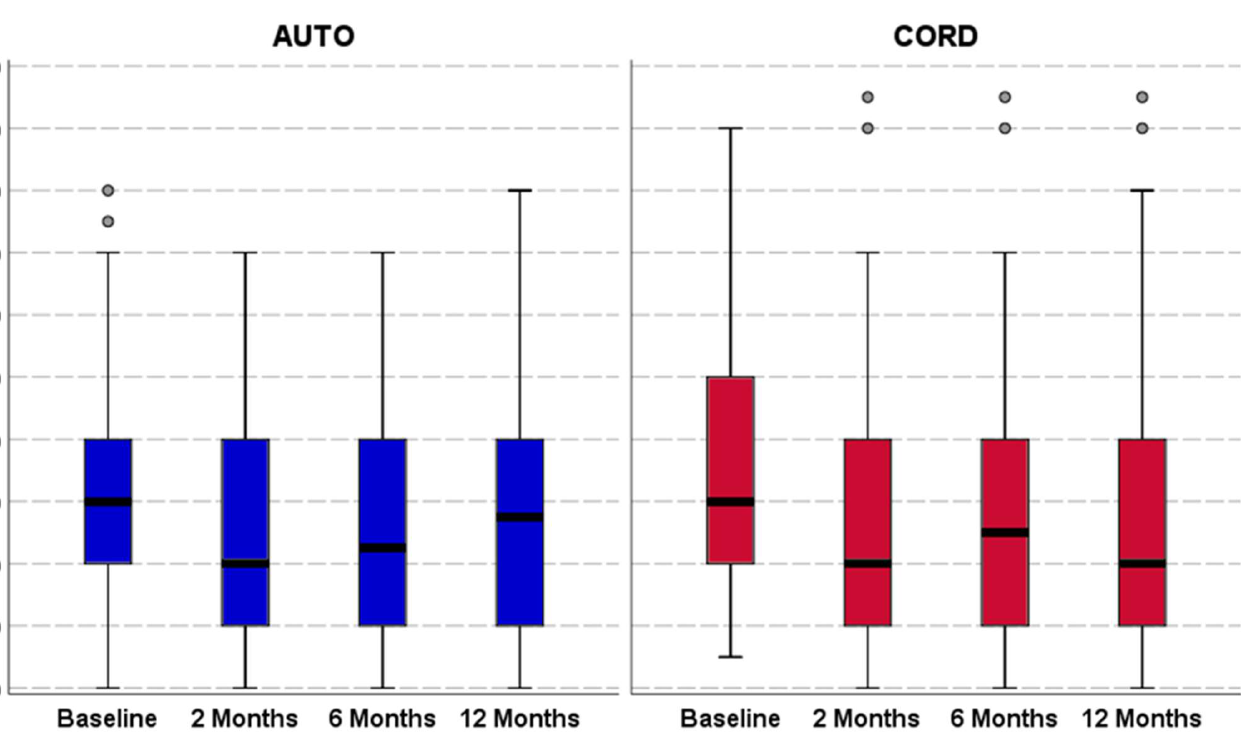
Figure 3. Visual analog scale (VAS; 0–100 points) trends in both treatment groups. The horizontal black line represents the median, the box limit represents quartiles, and error bars represent 95% Confident Intervals.